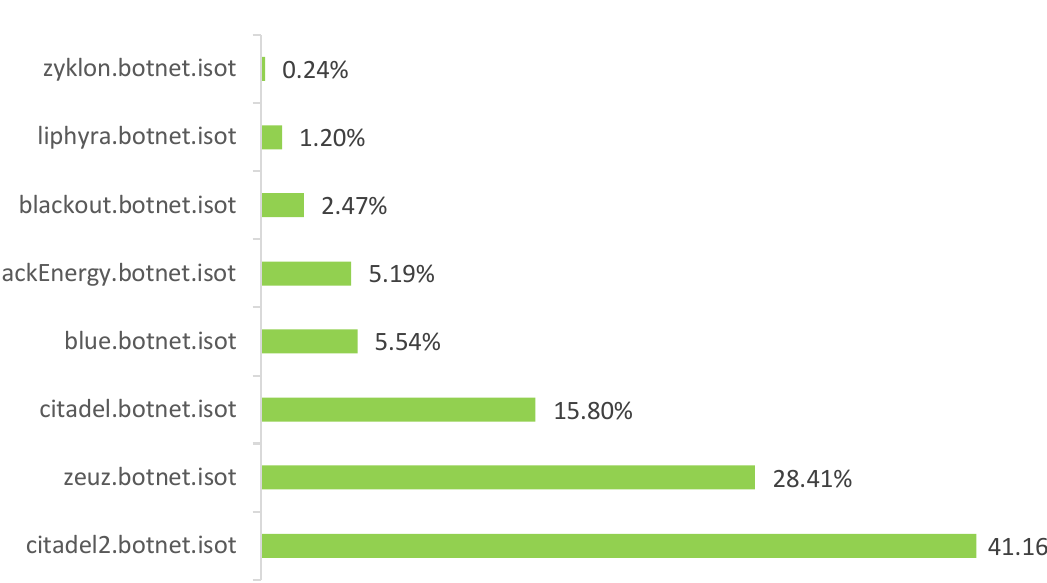
Figure 3. Distribution of botnet traffic samples grouped by class in the ISOT HTTP Botnet